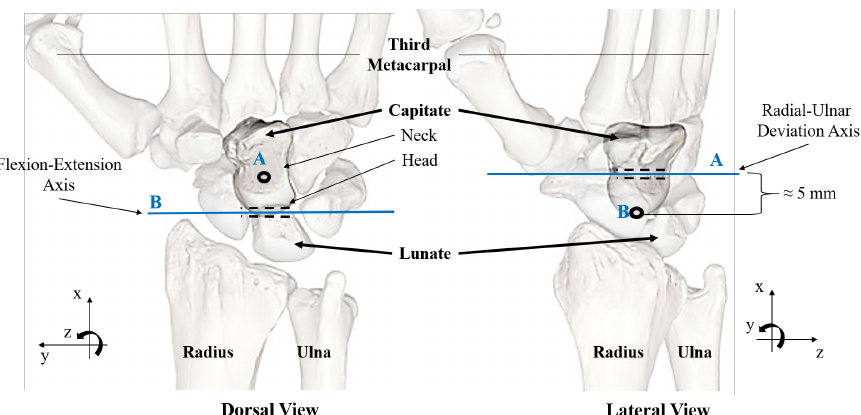
Figure 3. Highlighting the displacement between flexion/extension axis ( B ) and radial/ulnar devia- tion axis ( A ).